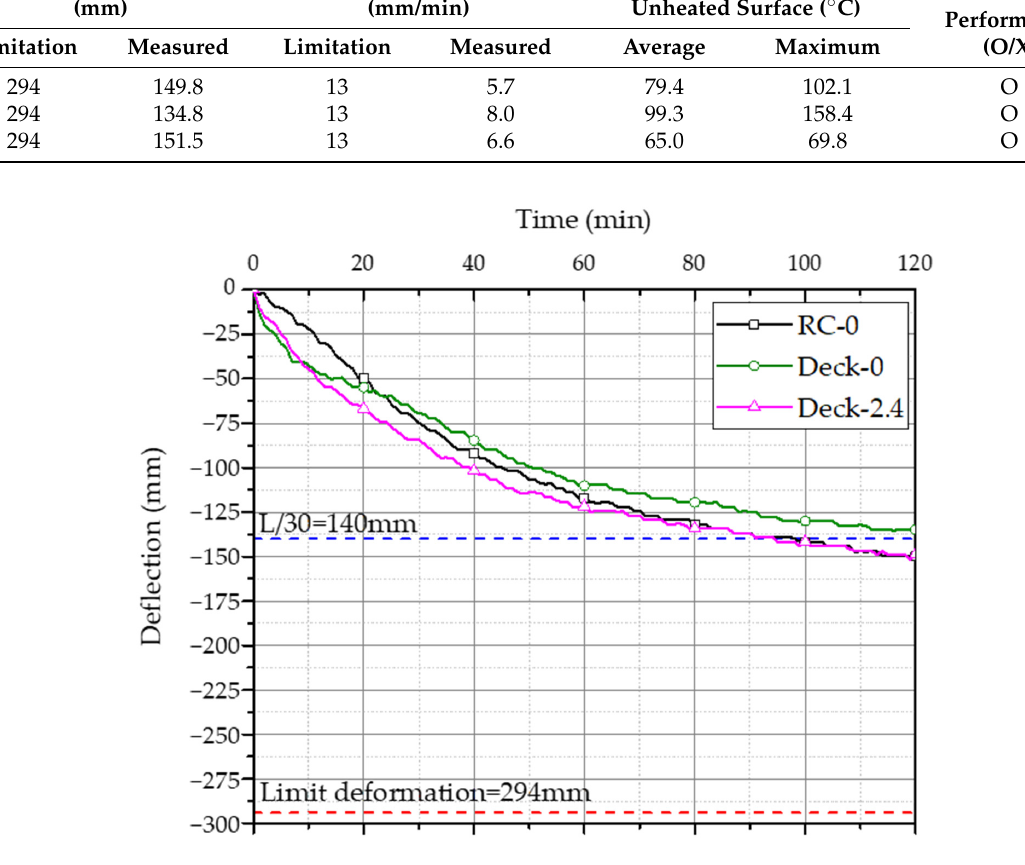
Figure 6. Deck slab deflection–time curve.